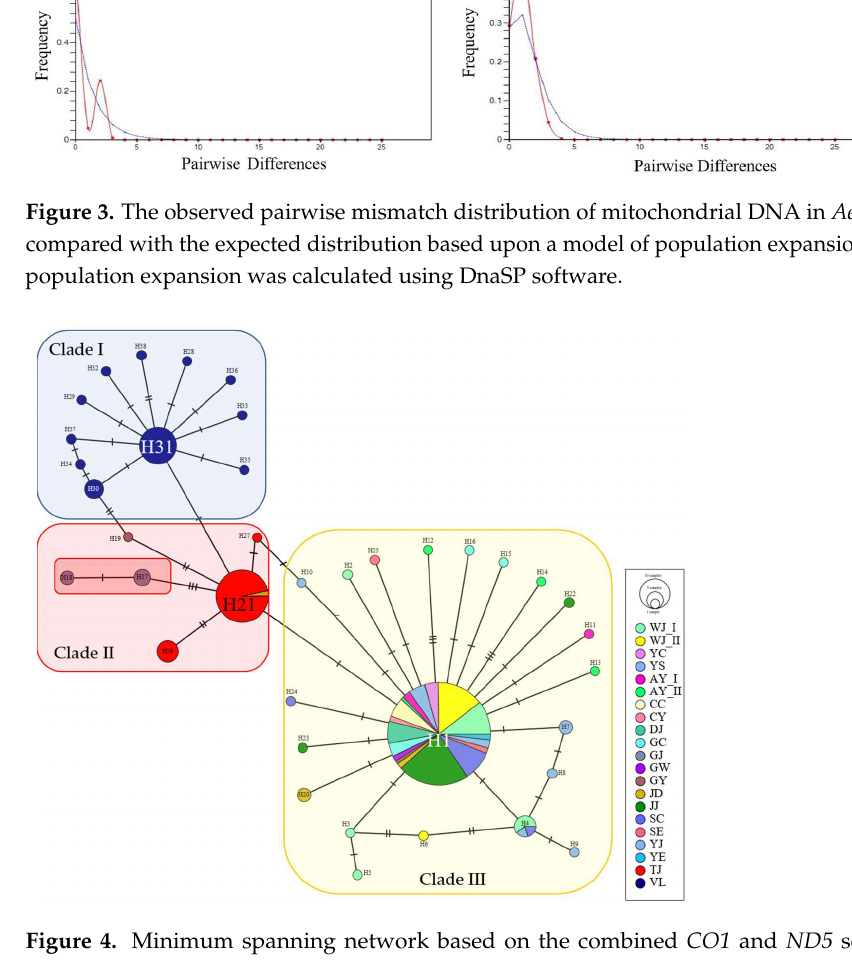
Figure 4. Minimum spanning network based on the combined CO1 and ND5 sequences of Ae. al- bopictus. The minimum spanning network algorithm as implemented in Population Analysis with Reticulate Trees, PopART, a web-based software package. The red-boxed Korean haplotypes (H17 and H18) were well connected to the Japanese clade (H21). Most of the Korean haplotypes are grouped, including H1 (yellow-boxed), Japan haplotypes are grouped, including H21 (red-boxed), and all Laos haplotypes are grouped, including H31 (blue-boxed). A detailed description is pro- vided in supplementary Figures S2 and S3. in supplementary Figures S2 and